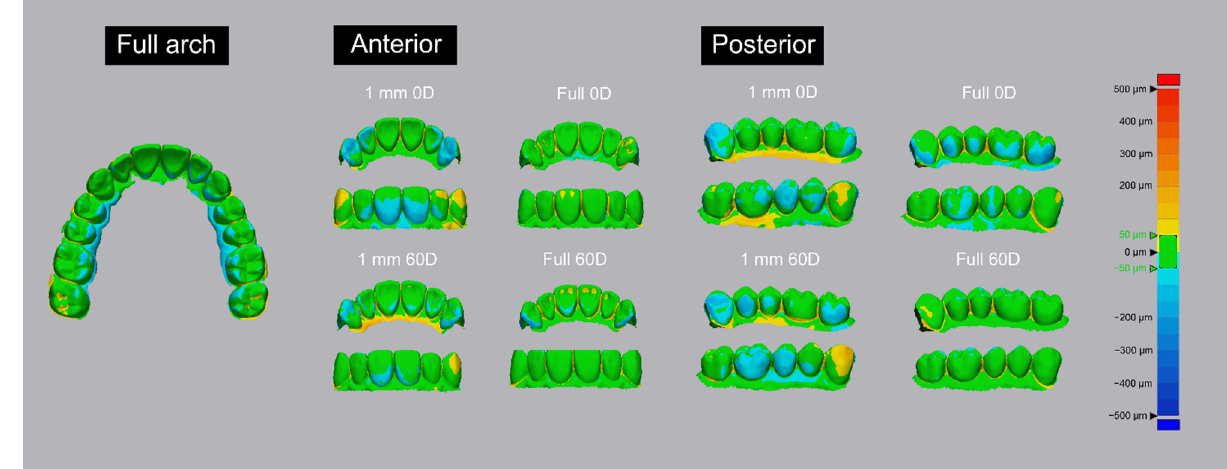
Figure 6. Scan color maps for each printing direction and outer wall thickness of the full-arch and anterior and posterior partial-arch groups. Comparisons with the full-arch group revealed that the anterior and posterior 0 degree partial-arch groups had large volume changes. For the 1-mm-thickness groups, the fully filled model and anterior and posterior partial-arch groups printed at 60 degree were compared, revealing relatively small volume changes.